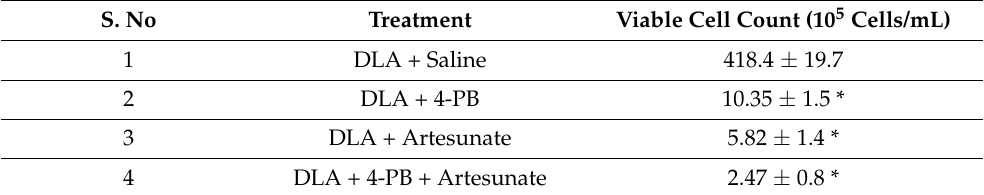
Table 1. Effect of drug treatment on DLA cell viability in mice. S. No